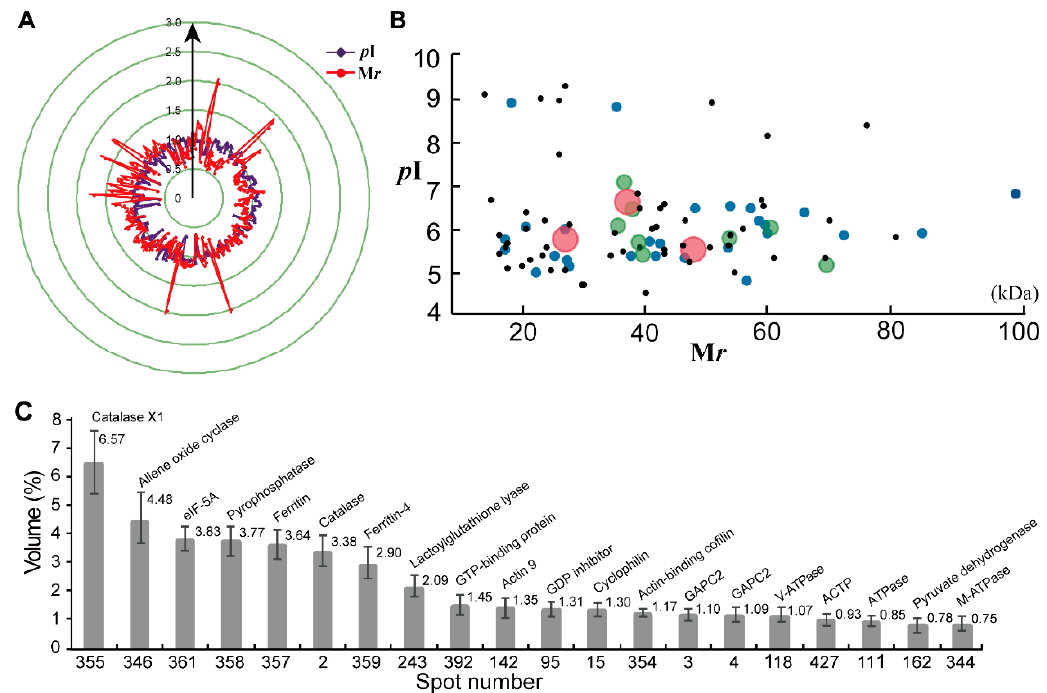
Figure 3. Distribution of the identified proteins on the reference 2-DE gel of 6M TKS roots. The theoretical and experimental ratios of M r and p I for the identified 371 are presented in radial charts with radial and annular radar axes ( A ). The theoretical distribution of M r and p I for the protein isoforms is highlighted ( B ). These protein isoforms were independently identified from two (black circle), three (blue circle), four (green circle), and five (red circle) spots on the reference 2-DE gels of the 6M TKS roots, respectively. The most abundant 20 proteins in the 2-DE gel of 6M roots are highlighted ( C ). The detailed identities for these protein isoforms are listed in Table S2.